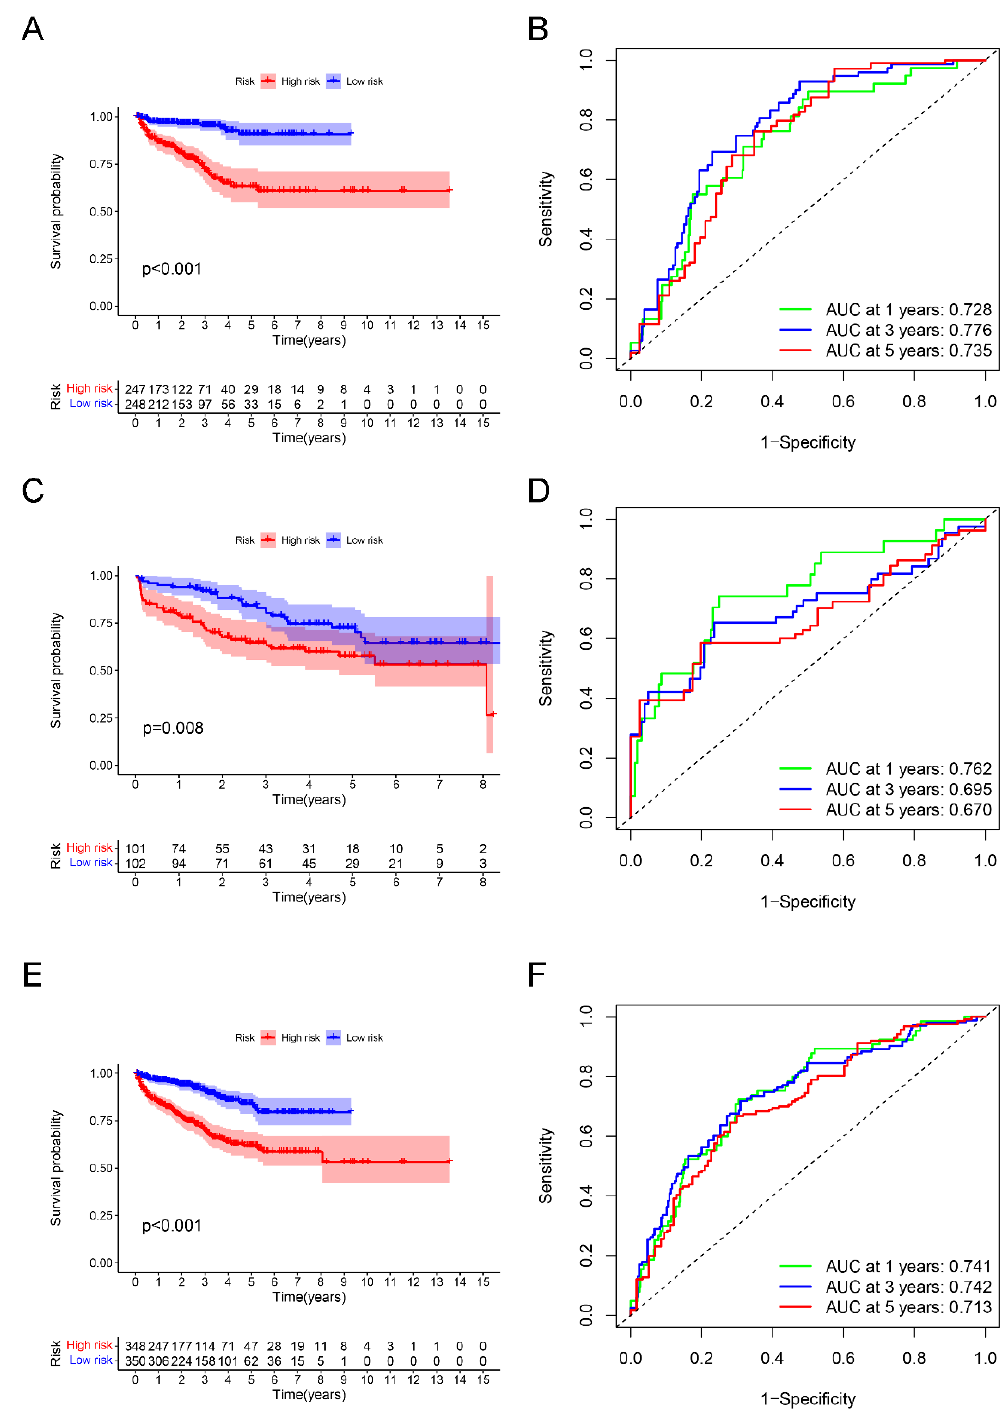
Figure 4. The survival analysis between high- and low-risk groups, and the corresponding area under ROC curve in the training cohort ( A , B ), testing cohort ( C , D ), and validating cohort ( E , F ).